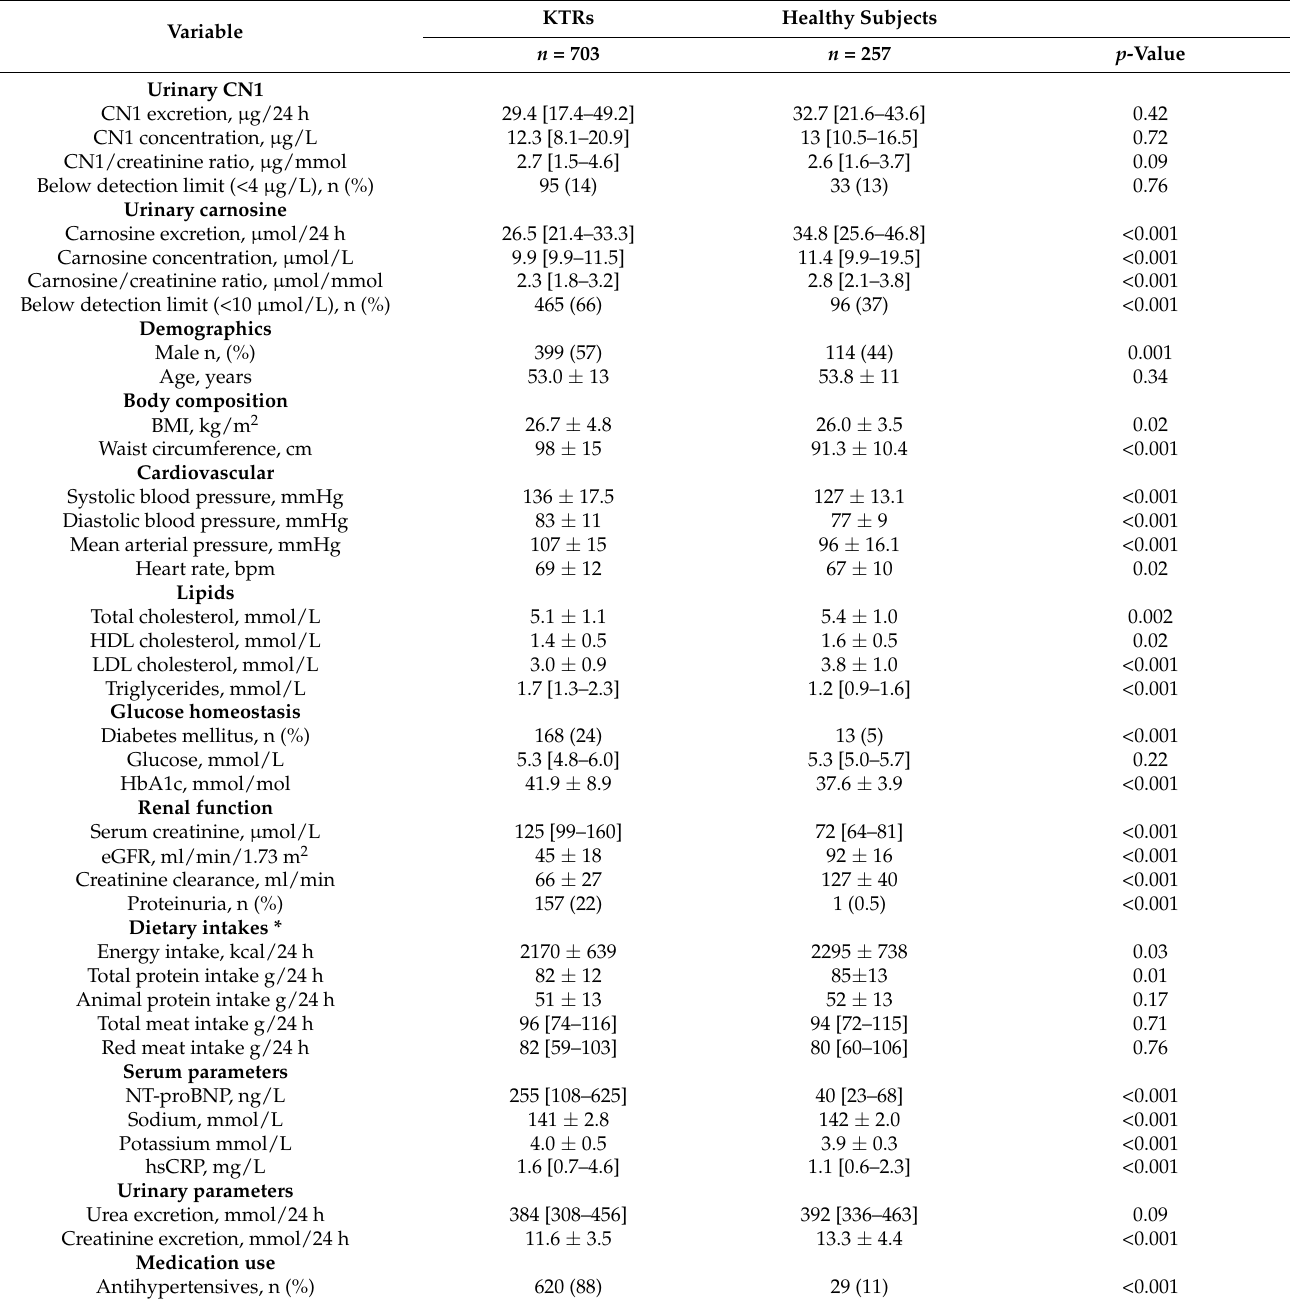
Table 1. Baseline characteristics of KTRs compared to healthy